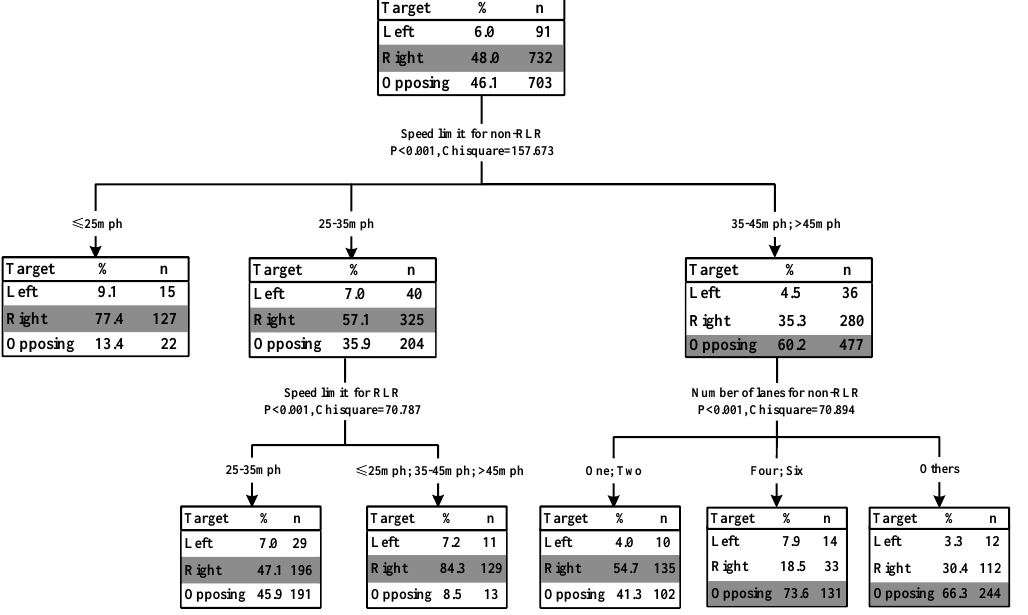
Figure 4. Tree model for RLR crash type #2 GS RLR and left-turn (LT) non-RLR.